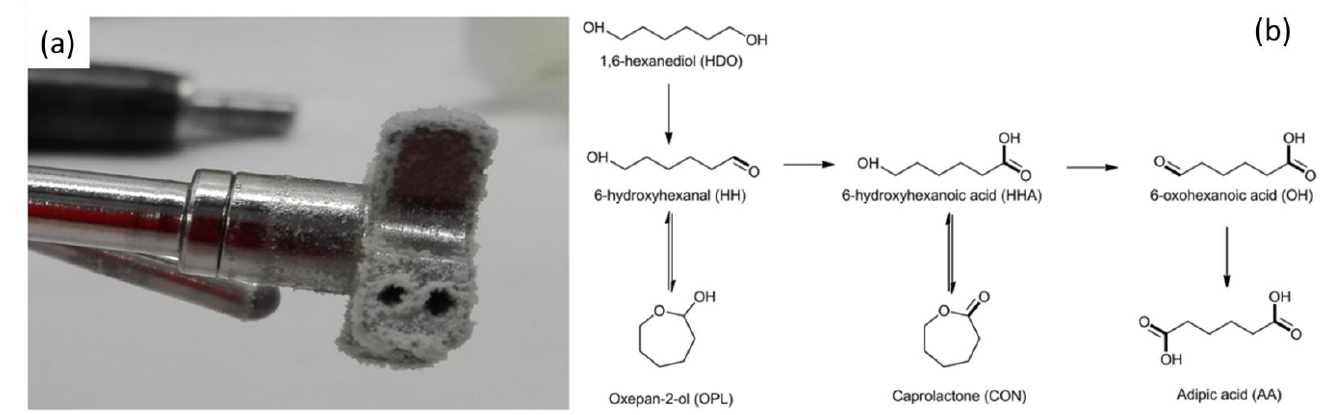
Figure 5. ( a ) Adipic acid formed from cyclohexane oxidation under solvent-free conditions; ( b ) adipic acid synthesis pathways from 1,6-hexanediol. Table 2. Effect of the time of 1,6 hexanediol oxidation reaction at 120 °C and 135 °C. Adapted with permission from Ref [36].